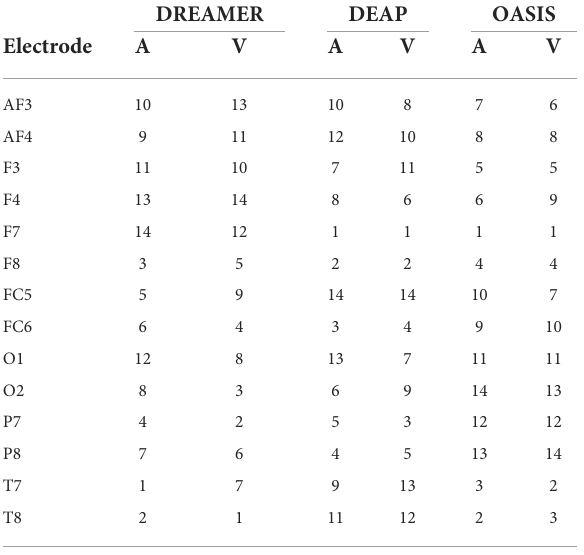
TABLE 2 Electrode ranking for valence label (V) and arousal label (A) based on SelectKBest feature selection method. DREAMER DEAP OASIS